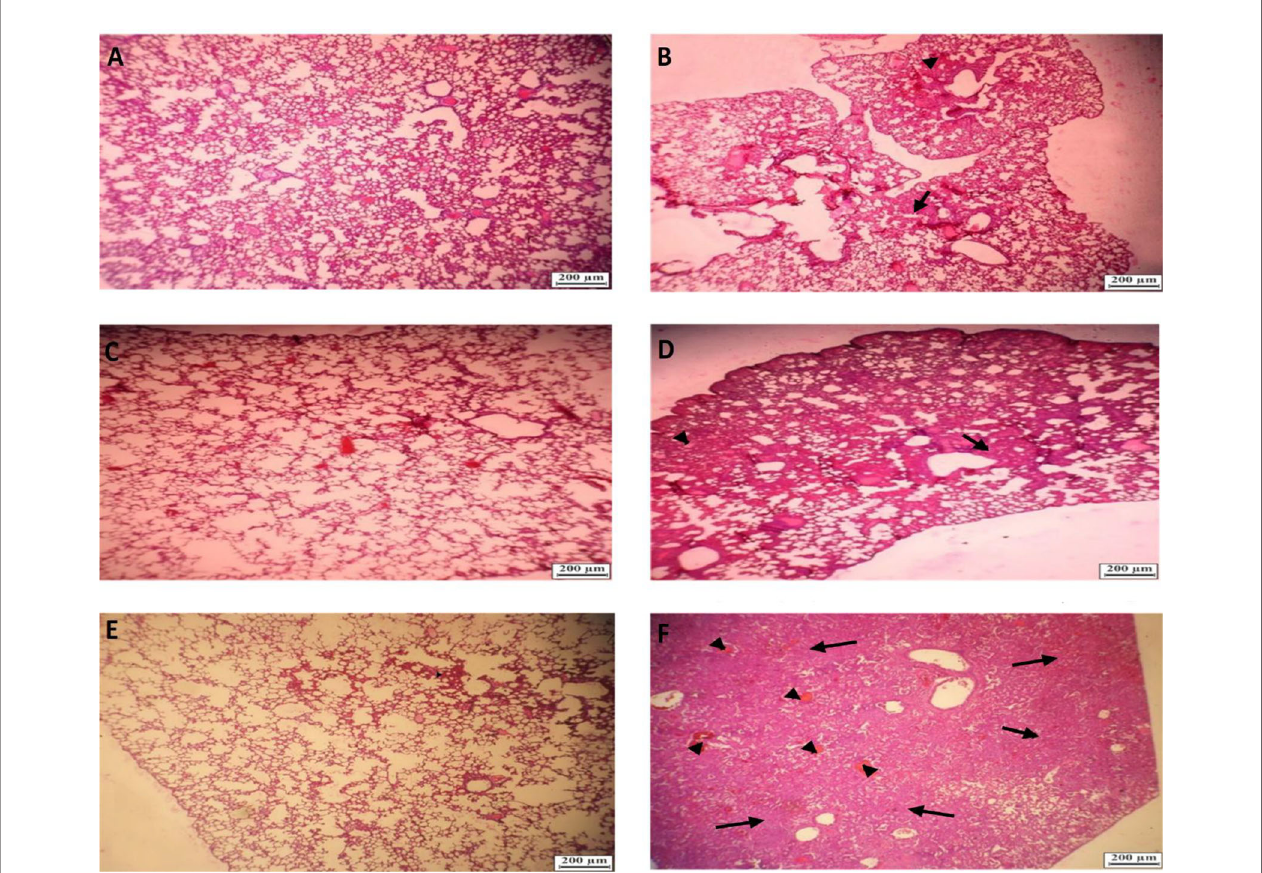
FIGURE 8 | Histopathological examinations in lungs f of hamster from challenged animals on 3, 5, and 7 DPI (day post-infection). (A) Lungs of hamster from vaccinated group on 3 DPI showing alveolar septa with mild thickened (Hematoxylin and eosin × 40). (B) Lungs of hamster from non-vaccinated hamsters ’ group on 3 DPI showing mild interstitial pneumonia (arrow) and small foci of hyperemia (arrowhead) (Hematoxylin and eosin×40). (C) Lungs of hamster from vaccinated hamsters challenged on 5 DPI showing foci of hyperemia (arrow) (Hematoxylin and eosin×40). (D) Lungs of hamster from non-vaccinated hamsters on 5 DPI showing moderate to severe interstitial pneumonia and lymphocytic in fi ltration (Hematoxylin and eosin× 40). (E) Lungs of hamster from vaccinated hamsters challenged on 7 DPI) Hematoxylin and eosin×40). (F) Lungs of hamster from non-vaccinated hamsters challenged on 7DPI showing severe interstitial pneumonia (arrow) and foci of hyperemia (arrowhead) (Hematoxylin and